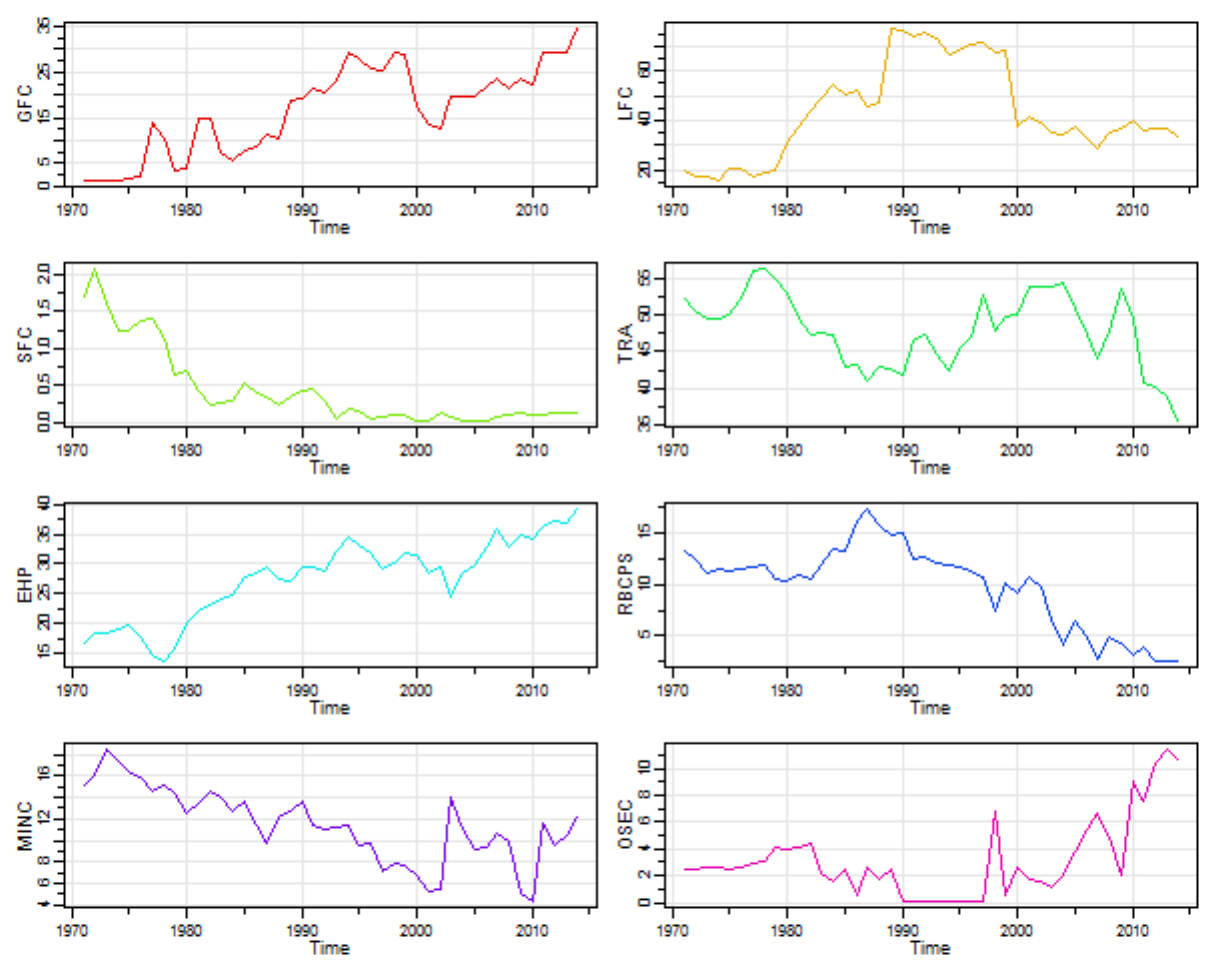
Figure 1. Time plot of CO 2 emissions data. Table 3. Modified Mann-Kendall analysis